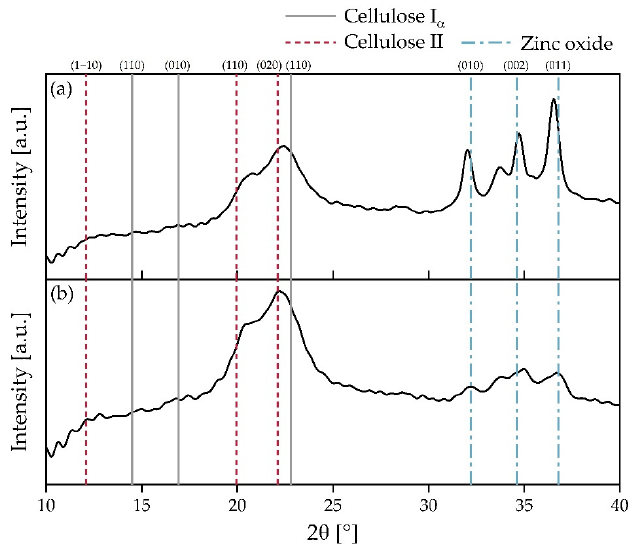
Figure 10. Diffraction patterns of bacterial cellulose (BC) separators ( a ) BC-10-L applied as stand- alone separator and ( b ) BC-10-L applied as separator in a combined approach with BC-10 after electrochemical cycling in a Ni-Zn